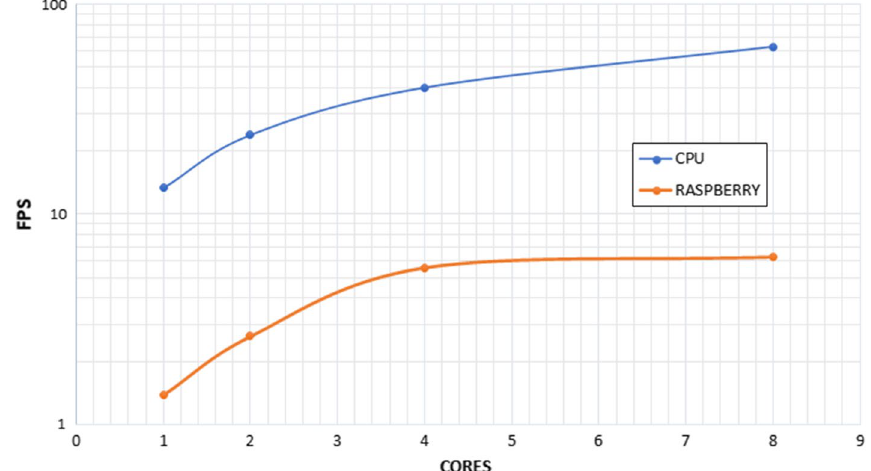
Fig. 6 Performance comparison with different